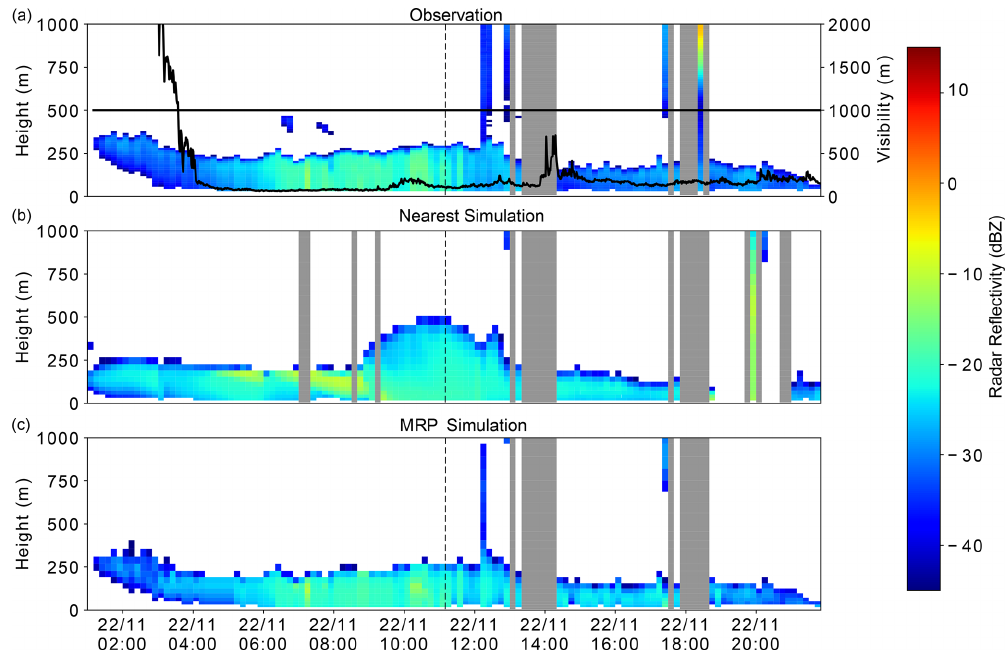
Figure 7. Radar reflectivity and surface level visibility from a fog event at SIRTA observed on 22 November 2018 (a) , simulated from the nearest grid point (b) , and with the MRP selection method (c) . The dashed black line indicates the time at which the following plot of reflectivity profiles is taken. These plots show the reflectivity for all profiles; profiles containing rain have been masked over in grey.